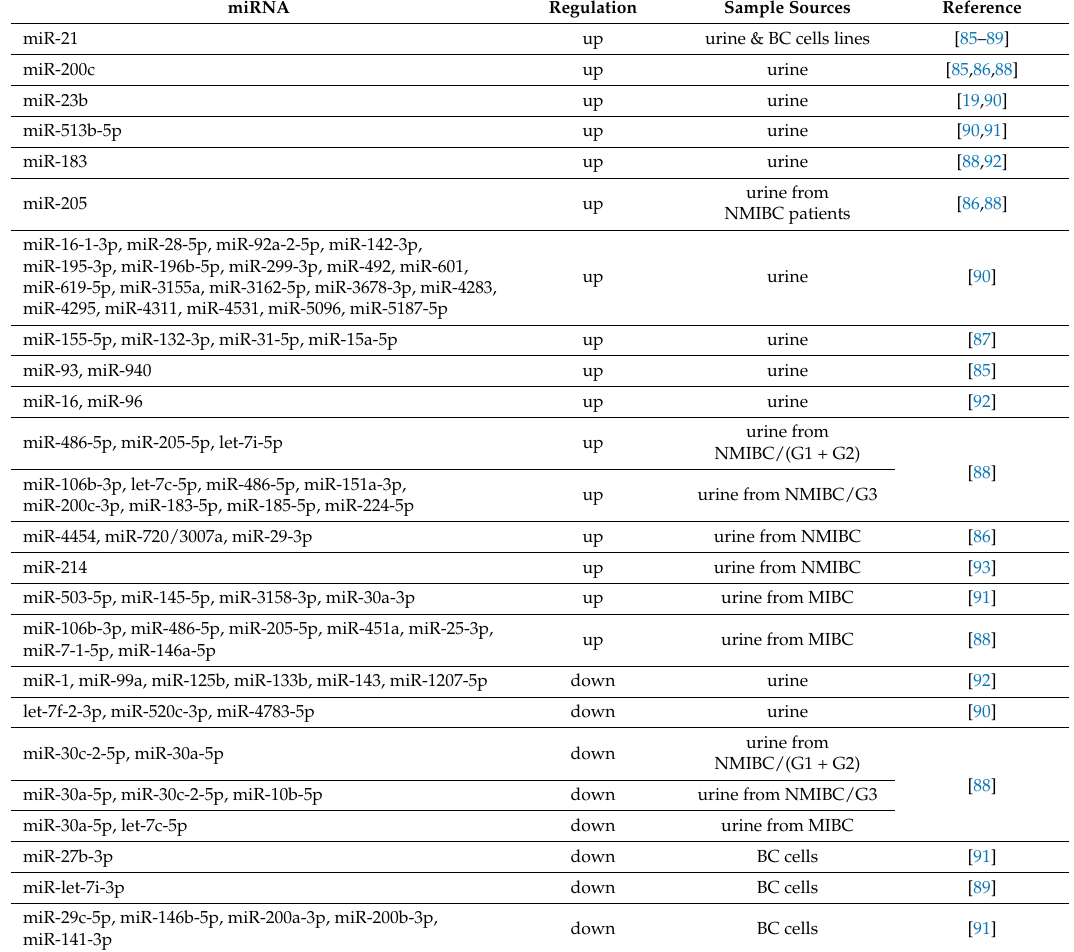
Table 1. List of miRNAs identified in BC urinary EVs and/or BC cells EVs. miRNA